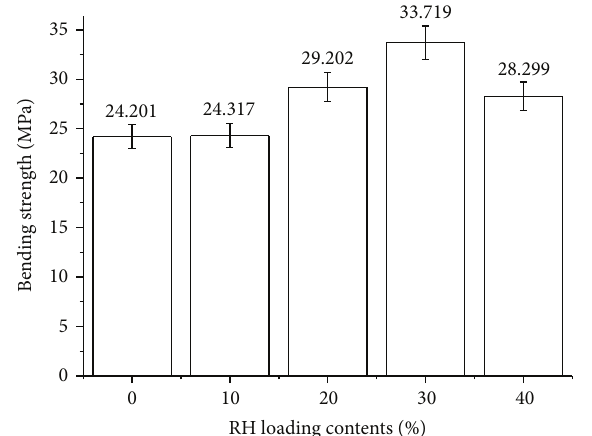
Figure 2: Bending strength of composites with different loading of rice husk fibers.